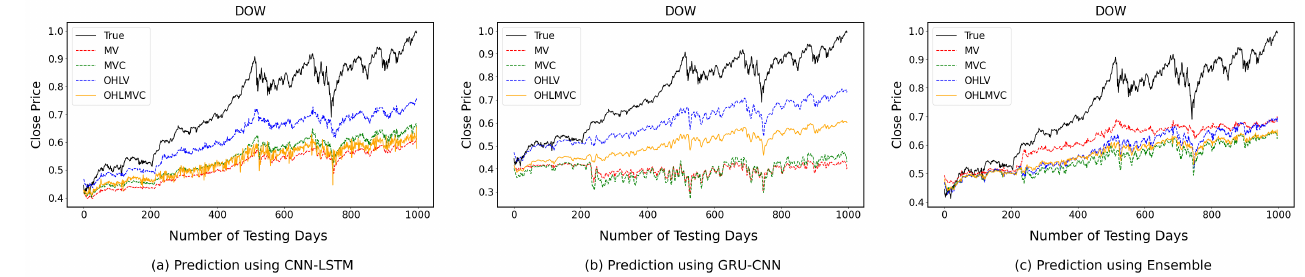
Figure 13. Comparison of true and predicted close prices of the DOW index between different input features for five-time-step prediction over the period from 1 January 2000 through 31 December 2019.